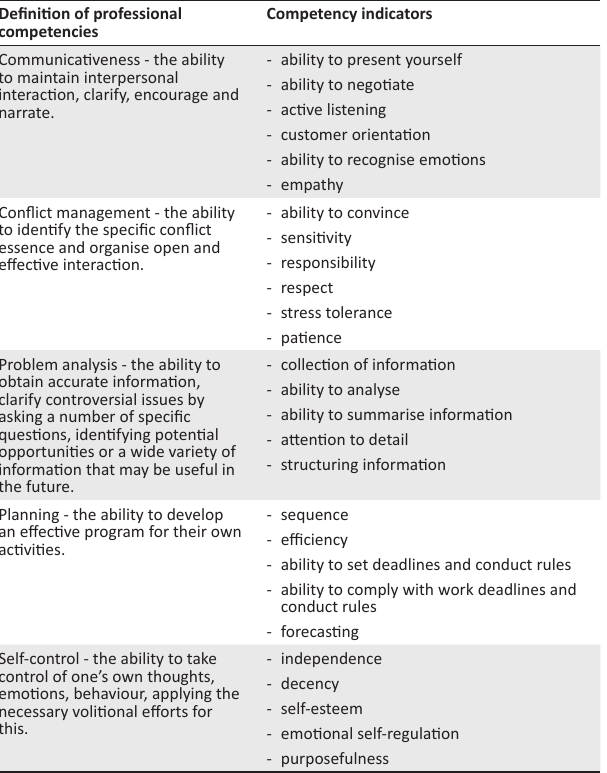
TABLE 2: Description of the mediator’s professional competence content and indicators in restorative mediation. Definition of professional competencies